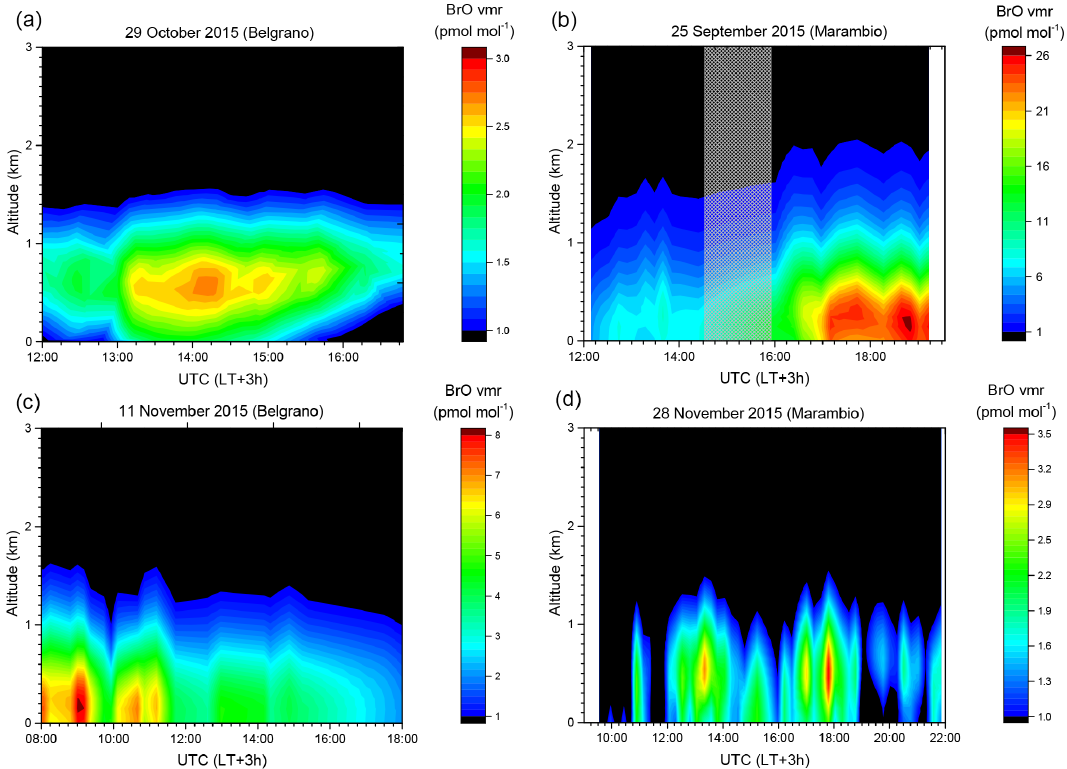
Figure 8. Examples of the daily and vertical evolution of BrO at Belgrano (a, c) and at Marambio (b, d) . The horizontal scales indicate the time of the day while the vertical scales show the altitude (small ticks indicate the vertical grid of the retrieval). The color code corresponds to the BrO vmr with values below detection limit shown in black. Observations below quality filters are indicated by the grey dashed area. Note the different vmr scales of each day.